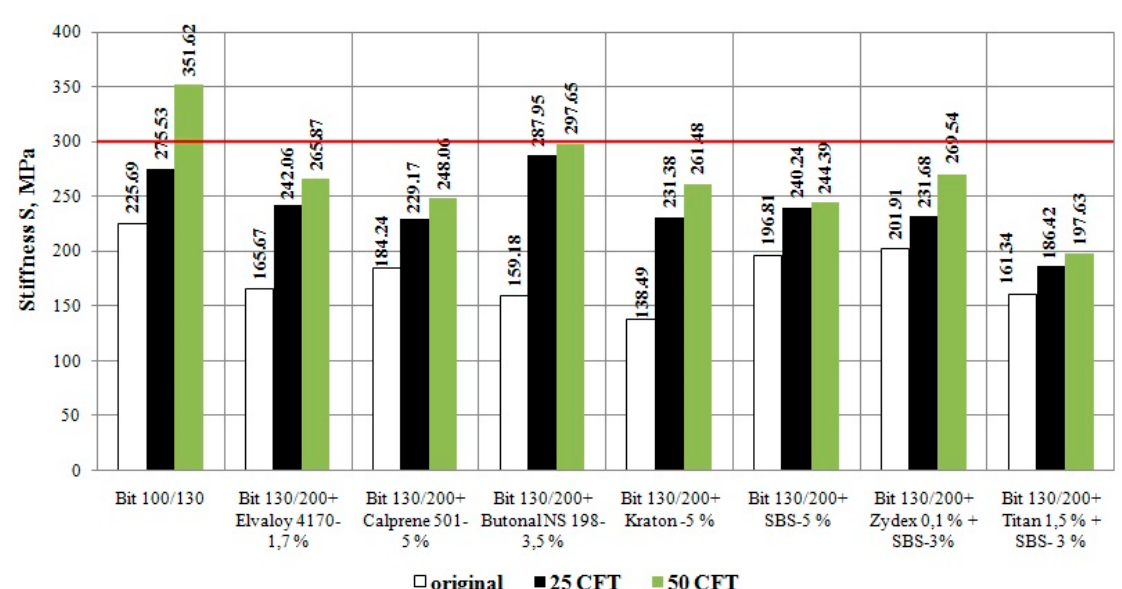
Figure 14. Bitumens stiffness at the temperature of –30° С .